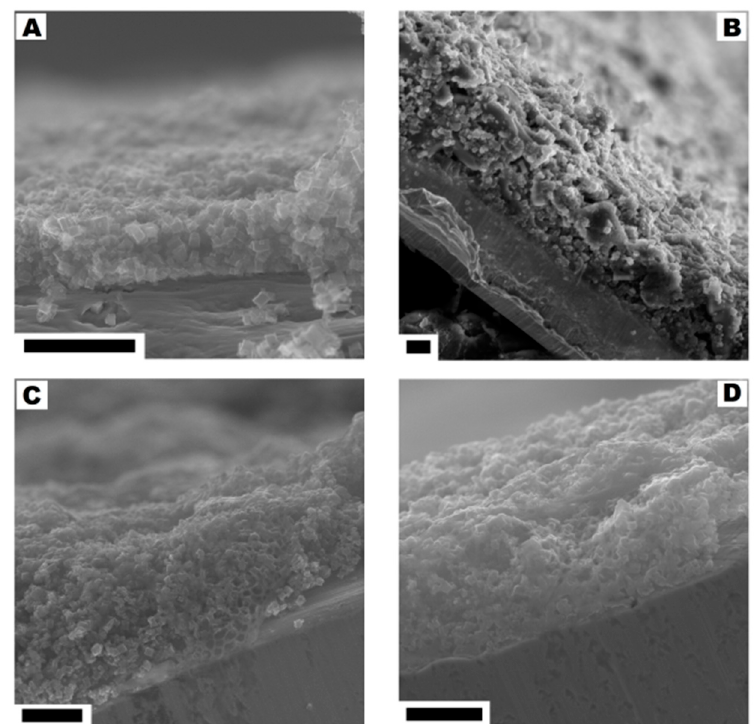
Figure 10. The cross-section of the electrodes corresponding to the CMOF-5:PVDF ratios: from 95:5 to 80:20 ( A ), 75:25 ( B ), 70:30 ( C ) and 60:40 ( D ). The scale bar corresponds to 20 µ m.